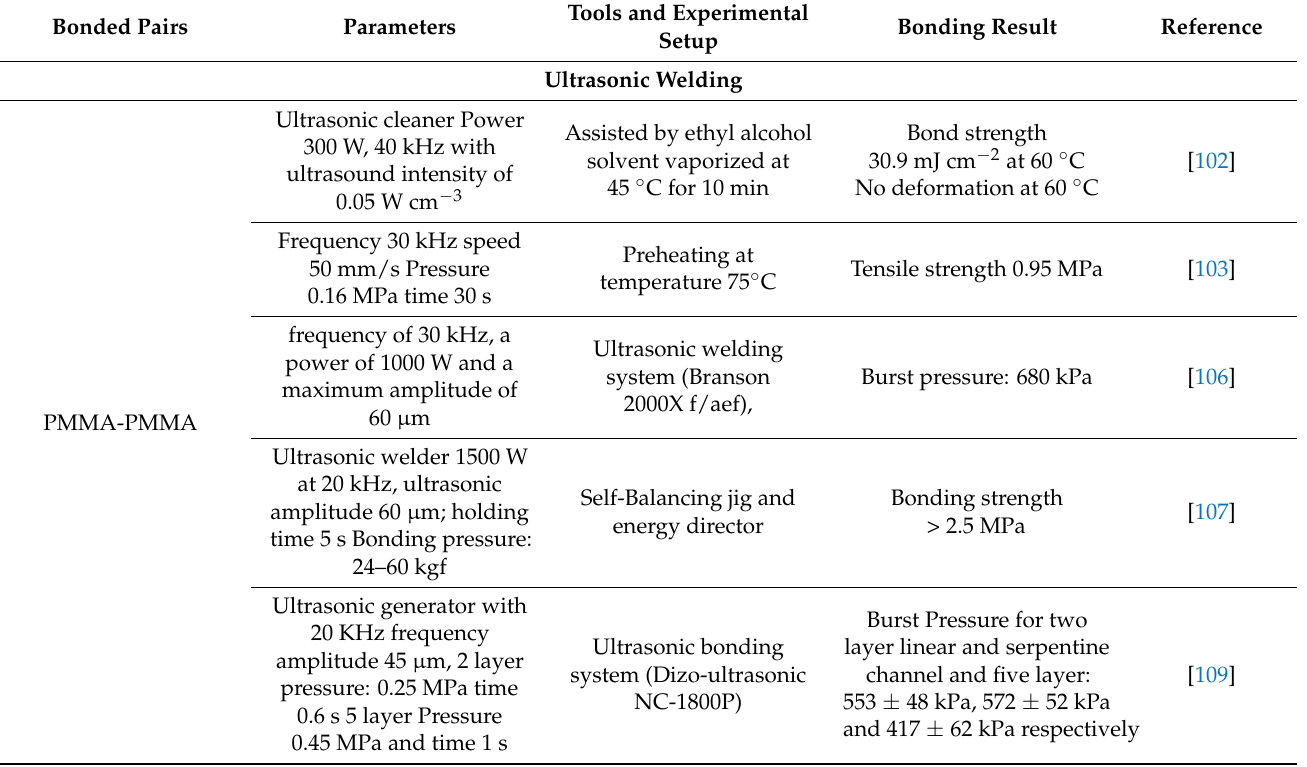
Table 4. Ultrasonic and laser welded pairs, parameters, tools required, and bonding result. Tools and Experimental Bonded Pairs Parameters Bonding Result Setup